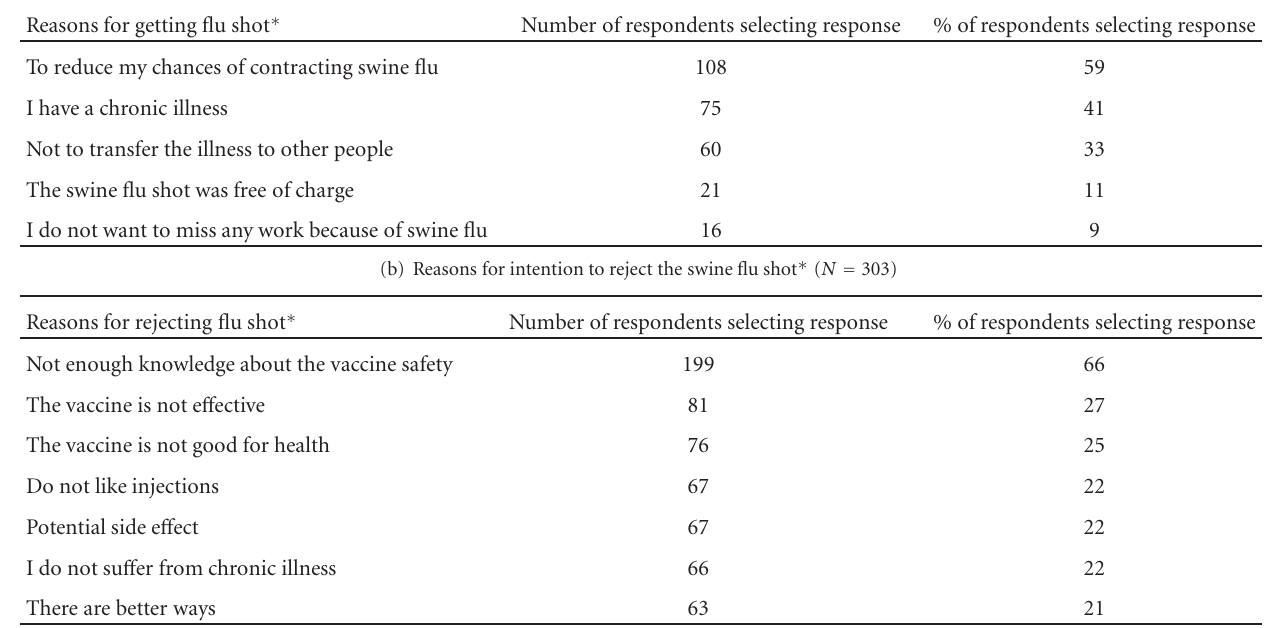
Table 3: Main reasons for intention to get or refuse the swine flu shot.